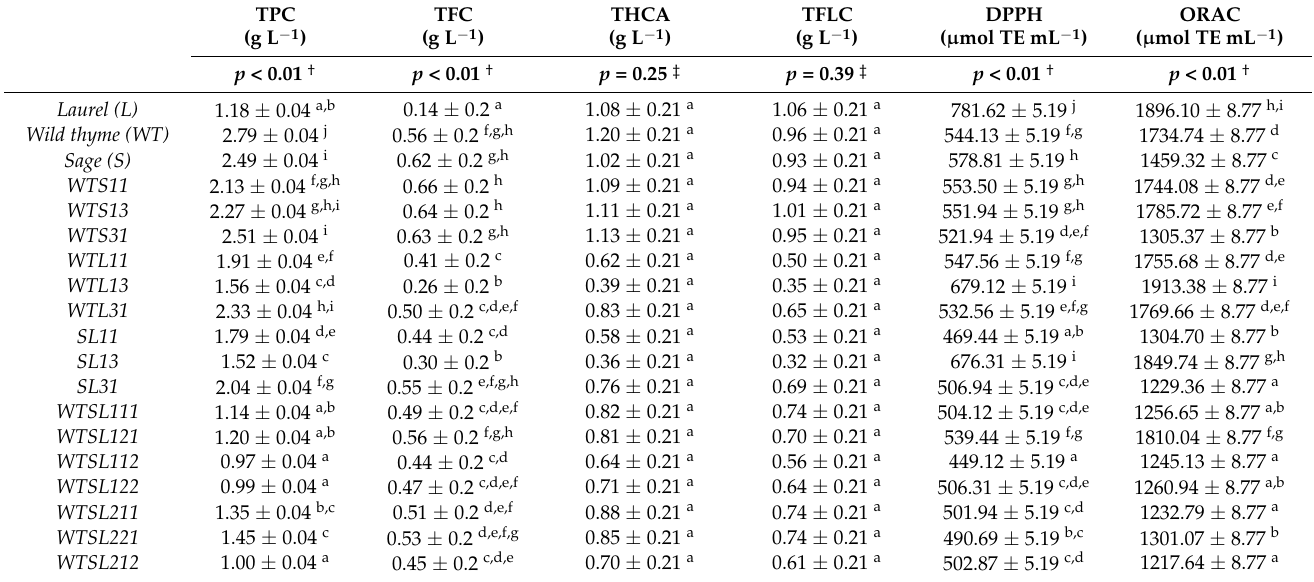
Table 2. Content of total phenols, flavonoids, hydroxycinnamic acids, flavonols and antioxidant capacity of laurel, wild thyme and sage extracts and their two- and three-component